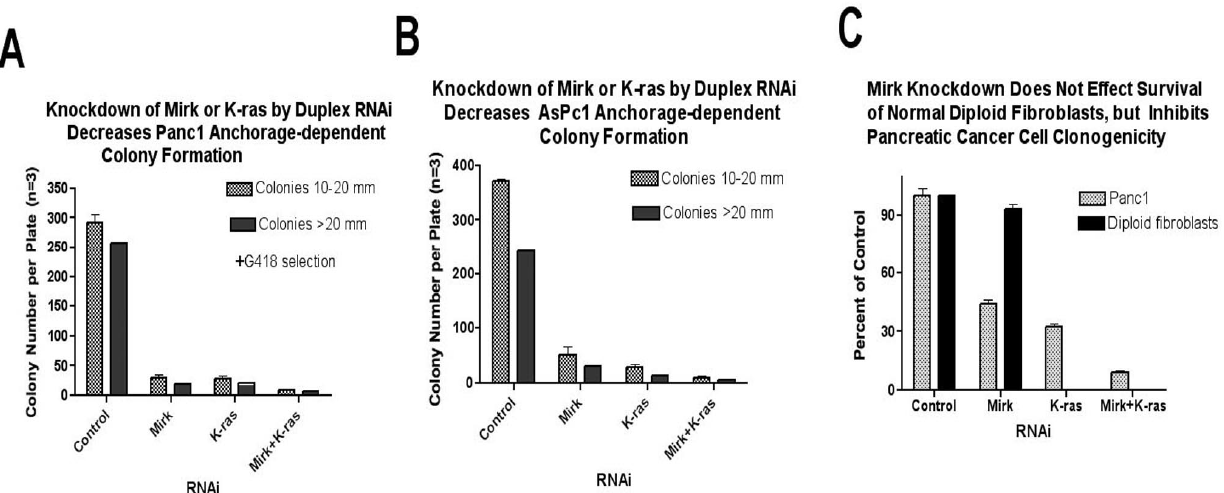
Figure 2. Depletion of either Mirk or K-ras inhibits anchorage-dependent colony formation in pancreatic cancer cells. ( A ) . Panc1 cells were depleted of Mirk, K-ras or both Mirk and K-ras by RNA interference, and pcDNA3-neoR was co-transfected to enable selection of the transfected cells. The transfected cells were maintained in serum-free medium for two days, and then allowed to proliferate in growth medium plus G418 for three weeks for colony growth. ( B ) . Colony formation as in A with AsPc1 pancreatic cancer cells. ( C ) . Experiment as in A with Panc1 cells without co-transfected pcDNA- neoR. Normal diploid BJ fibroblasts were depleted of Mirk, plated at 2000 cells per 100 mm dish, and then allowed to grow into cell clusters for three weeks. Approximately 1500 cell clusters were seen in the control. G418 selection was not employed for either cell